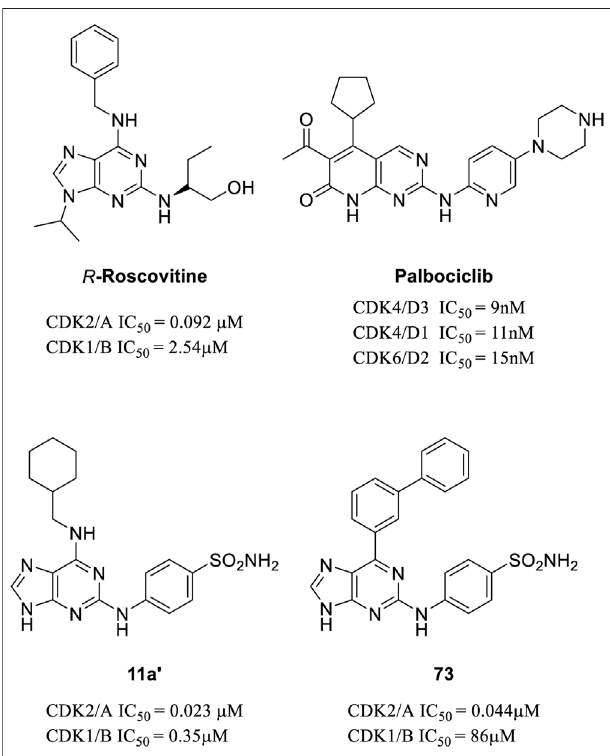
FIGURE 1 | Reported CDK2 inhibitors from literature and our previous work: R -Roscovitine (Meijer et al., 1997), Palbociclib (Fry et al., 2004), compound 11a ’ (Wang et al., 2013), and compound 73 (Coxon et al.,